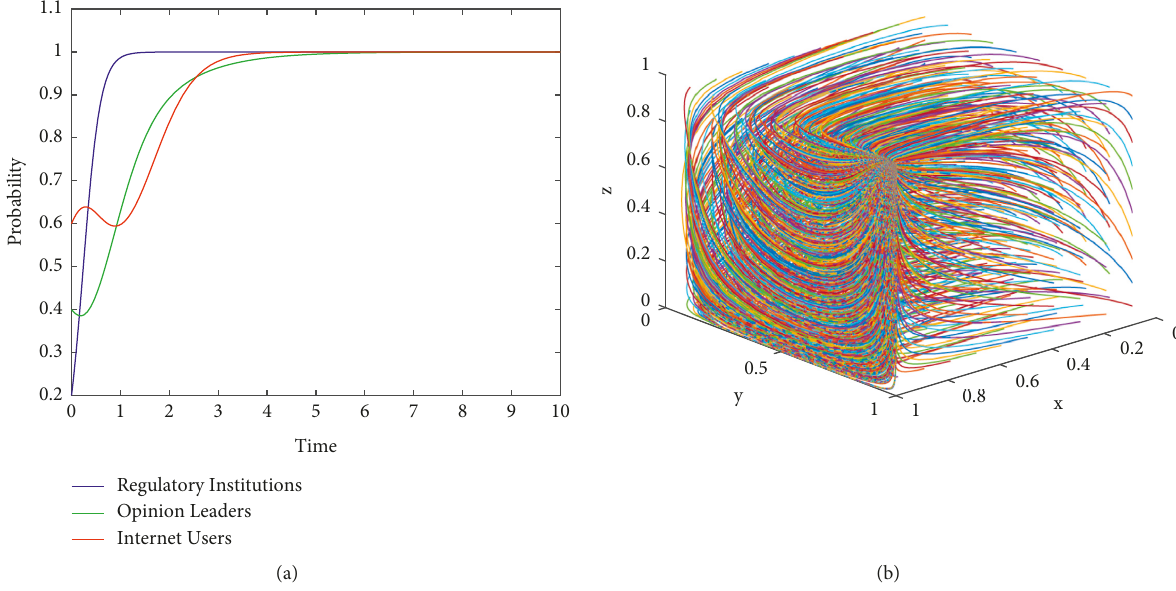
Figure 4: Tripartite evolutionary game trending figure stable at point E 8 (1,1,1) between “regulatory institutions, opinion leaders and Internet users”. (a) Strategy selection process. (b) 3D simulation diagram of the